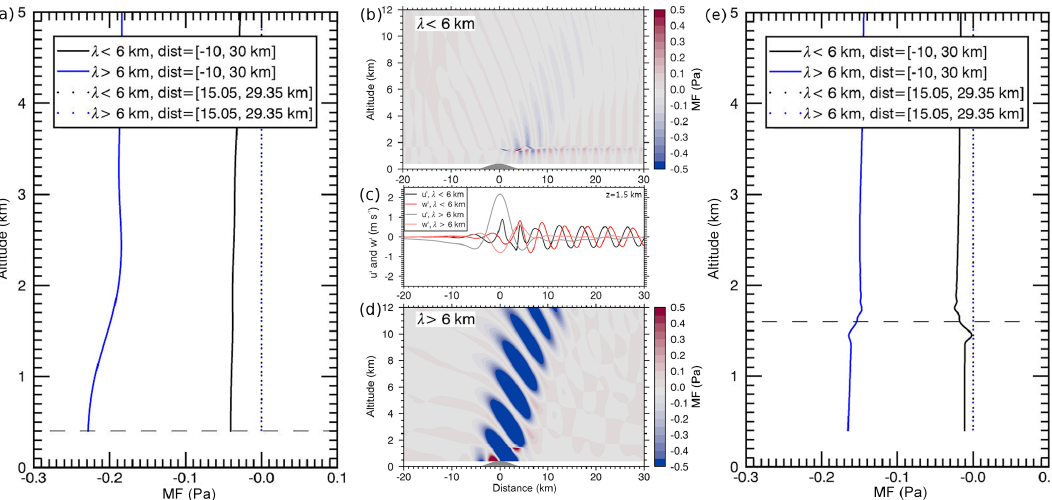
Figure 13. Momentum flux (profiles) for (a) run 1 without boundary-layer inversion (Figs. 11a, 12a) and (b, d, e) run 2 with boundary-layer inversion (Figs. 11b, 12c) for two wave classes (horizontal wavelength smaller or larger 6km). Profiles show averages for the full distance (solid) and for the downstream distance (dotted); horizontal dashed lines marks the top of the boundary layer. Panel (c) shows u (cid:48) and w (cid:48) for the two wave classes at 1.5km altitude revealing their phase relationship right below the inversion, i.e. − 90 ◦ for interfacial waves (black and red